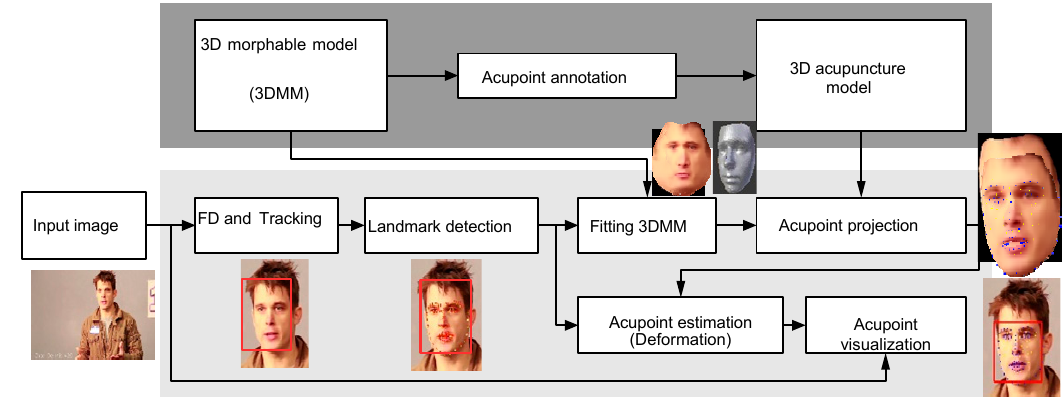
Figure 2. Flow chart of 3D acupuncture point estimation.